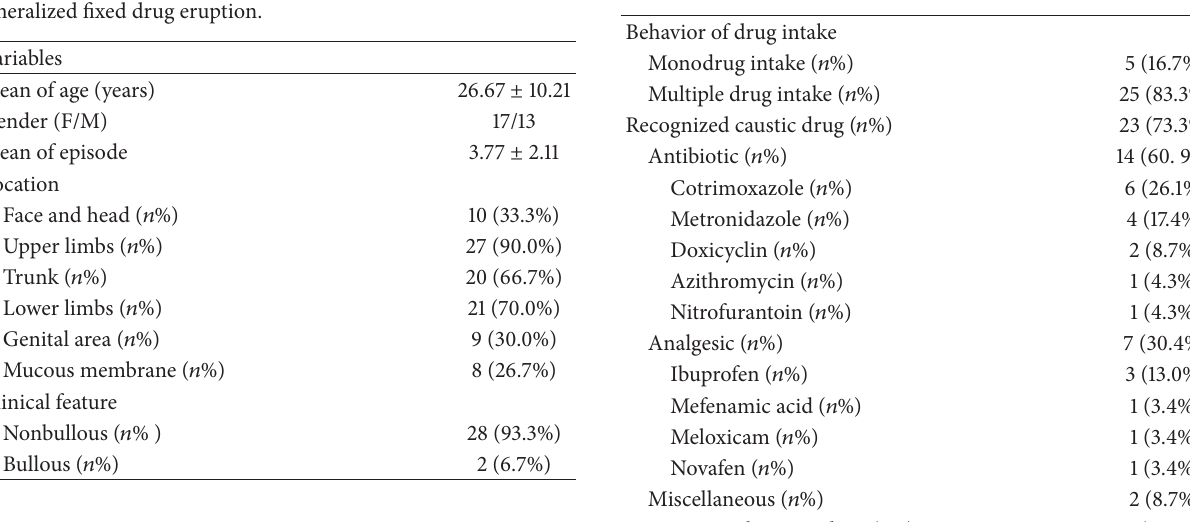
Table 2: Drug behavior and offending